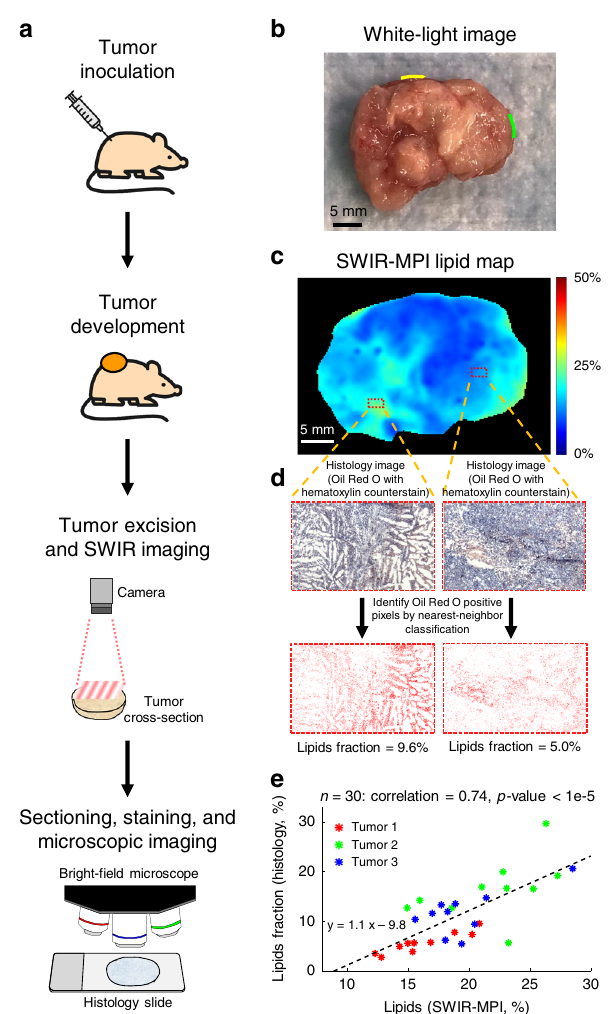
Fig. 3 Ex vivo mapping of tumor lipid heterogeneity. a SCID mice were inoculated with PC3/2G7 prostate tumor cells. After tumors reached 3,000 mm 3 they were excised, bisected, and the cross-section was imaged with SWIR-MPI. Tumors were then sectioned, stained with Oil Red O, and imaged under bright- fi eld microscopy for lipid fraction analysis. b . White- light image of a representative tumor cross-section. Green and yellow marks were made with permanent inks to aid in co-registration with histology (digitally added to the image here). c Lipid content map generated with SWIR-MPI. The area within the red box was spatially co-registered to the Oil Red O histology slide (counterstained by hematoxylin) for comparison. d A binarized lipid map was generated using nearest-neighbor classi fi cation from the histology data in order to calculate lipid area fraction. The lipid fraction was calculated as the number of Oil Red O positive pixels over the total number of pixels within the ROI (2.2 mm × 1.2 mm). e Correlation plot of lipid content obtained by SWIR-MPI and Oil Red O histology. Each data point in the plot corresponds to a sub-region on the histology slide. The black dashed line indicates the best fi t line and data from different tumors are indicated by color. The Pearson correlation coef fi cient is indicated. Source data are provided as a Source Data fi le. The pictures of the mouse and needle in a were generated using Google